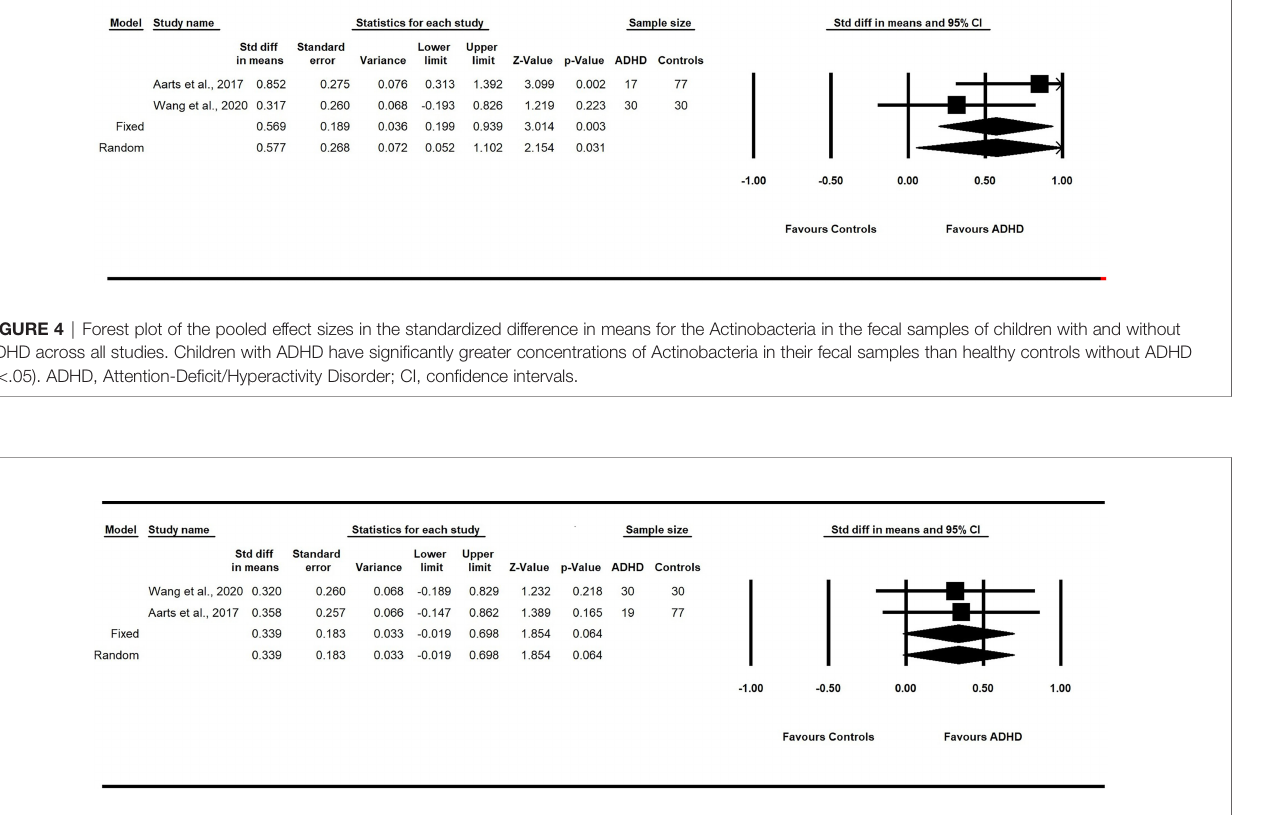
FIGURE 5 | Forest plot of the pooled effect sizes in the standardized difference in means for the Bacteroidetes in the fecal samples of children with and without ADHD across all studies. Bacteroidetes may be elevated in children with ADHD compared to healthy controls without ADHD ( p =.064). ADHD, Attention-De fi cit/ Hyperactivity Disorder; CI, con fi dence intervals.